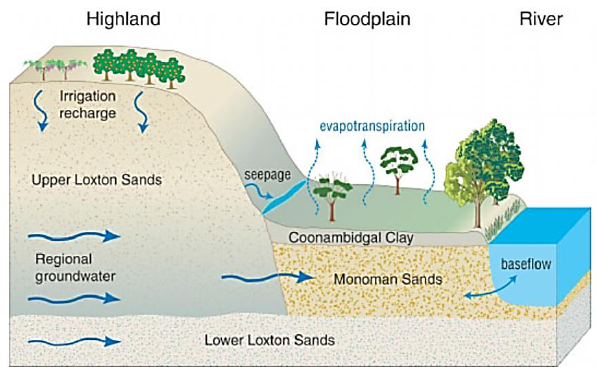
Figure 1 Conceptual model of groundwater inputs to the floodplain and potential groundwater discharge pathways Fig. 1. Conceptual model of groundwater inputs to the floodplain within the floodplain in the Lower River Murray (Holland et al., 2009a). and potential groundwater discharge pathways within the floodplain in the lower River Murray (Holland et al.,